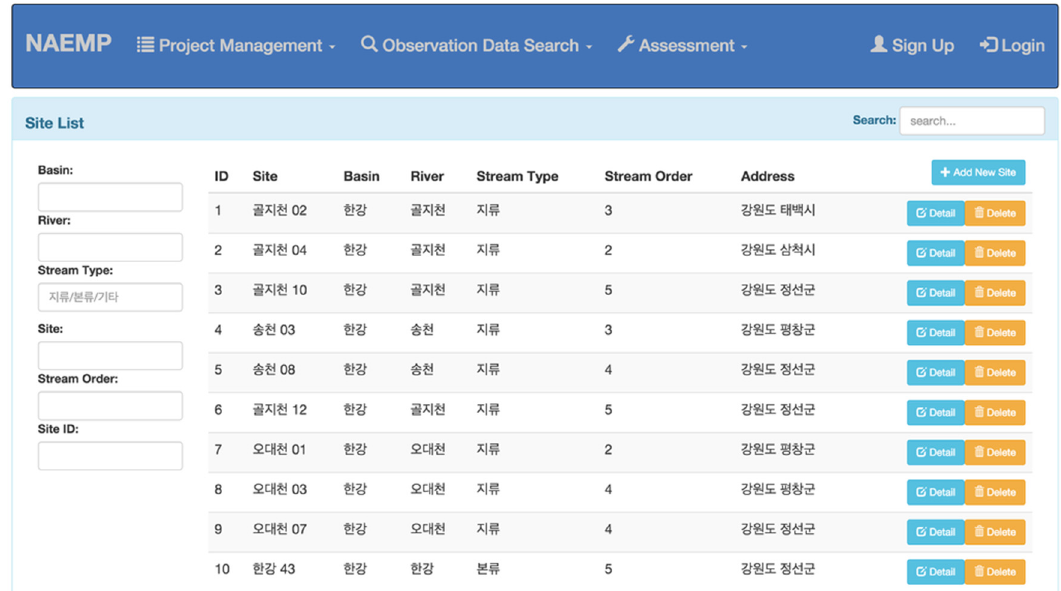
Figure 10. GUI window for the Site collection